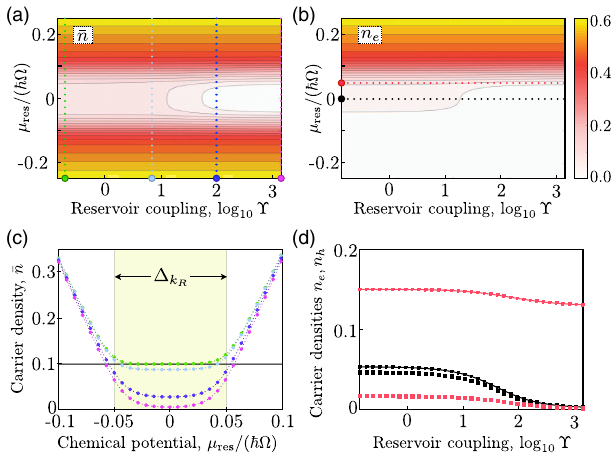
FIG. 5. Electron and hole densities n and n in the steady state e h of the system coupled to bosonic baths (acoustic phonons and recombination) and an energy-filtered fermionic reservoir. The figure clearly demonstrates that (1) the steady-state densities n e and n are insensitive to small shifts of the reservoir ’ s chemical h near the middle of the Floquet gap and (2) a potential μ res sufficiently strong coupling to the reservoir can effectively suppress the electron and hole densities when μ is within res n the Floquet gap. (a) The total density ¯ n ¼ n as a function of e þ h the Fermi level of the reservoir μ and the coupling strength ratio res ϒ ¼ 2 Γ 0 = W rec . As long as μ is within the Floquet gap, n e res k R ; þ and n remain low. Once μ enters the Floquet þ or − bands, the h res system becomes metallic and the electron (hole) density n ( n ) is e h set by the Fermi level of the reservoir. This behavior is seen in (b), where we plot n . To further demonstrate the incompressible e regime, in (c) we show ¯ n as a function of μ for several coupling res strengths to the reservoir, corresponding to the dotted lines in (a). (d) The electron and hole densities n (circles) and n (squares) e h for two values of μ in the middle of the Floquet gap (black) and res at the edge of the þ Floquet band (red). In the first case, the results explicitly demonstrate the suppression of the excitation densities n and n with increasing reservoir coupling. Model e h parameters are the same as in Fig.